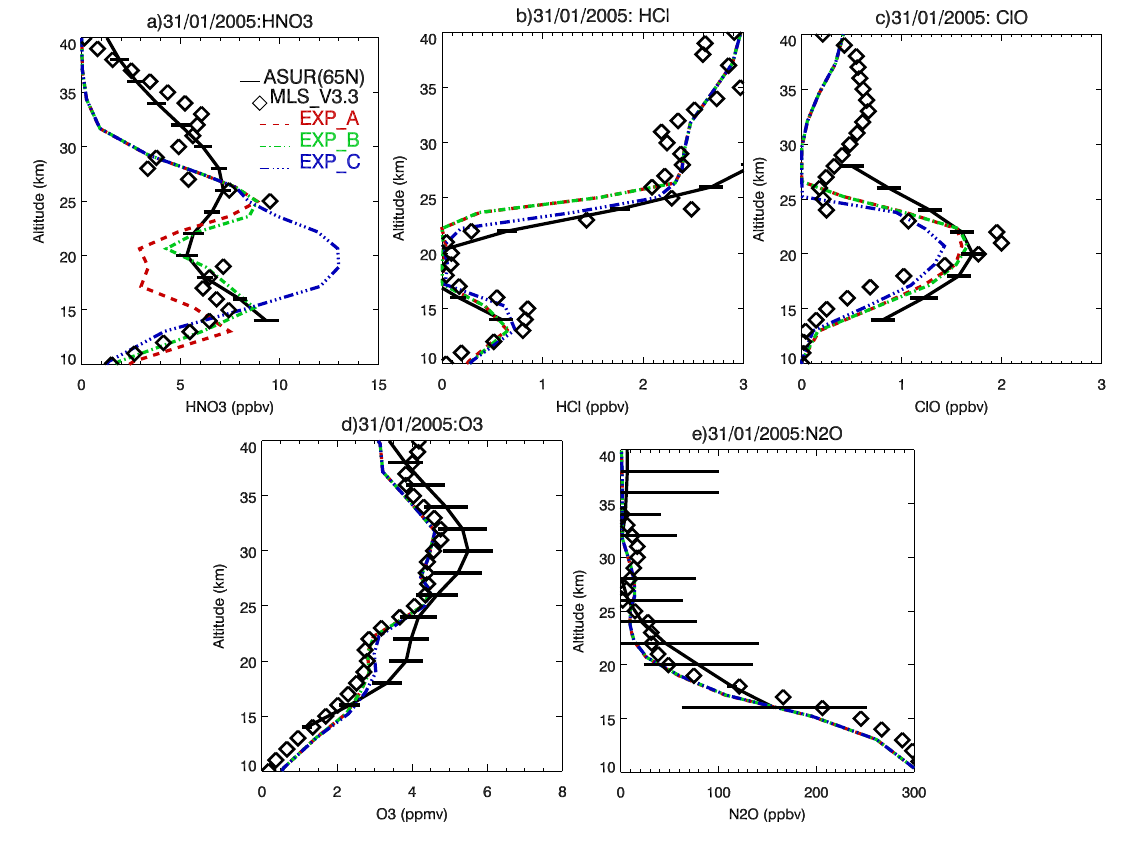
Fig. 1. Profiles of HNO 3 , HCl, ClO, O 3 and N 2 O from ASUR and MLS observations and model simulations using the equilibrium (EXP A), DLAPSE (EXP B) PSC schemes and without denitrification (EXP C) for 31 January